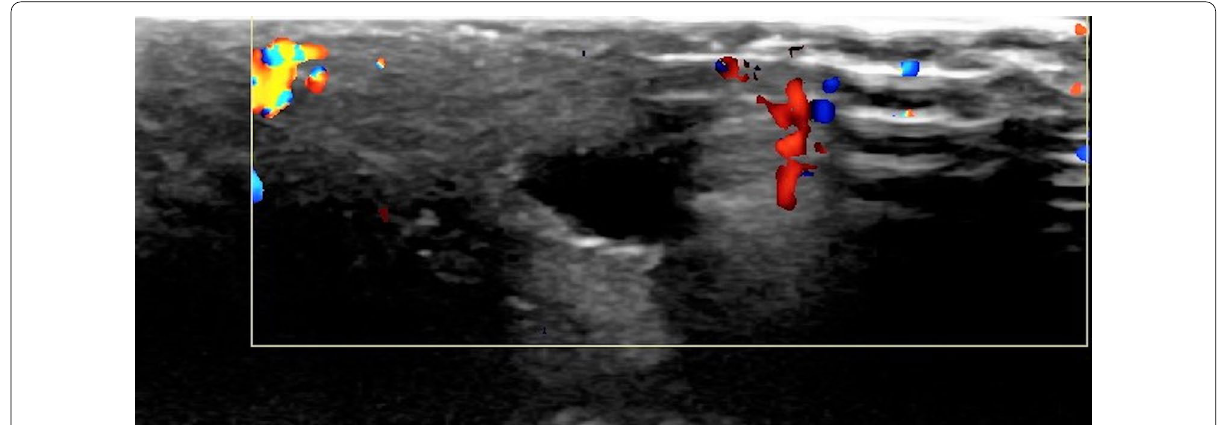
Fig. 2 There was no vascularization at the Doppler ultrasonographic evaluation of the same structure indicating an obstructing